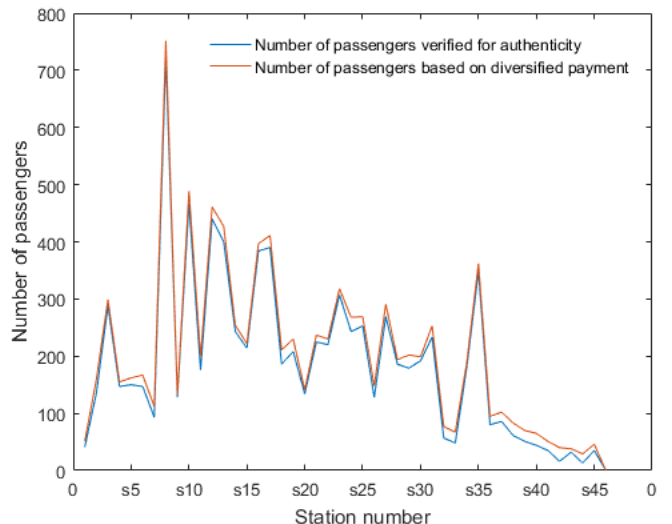
Figure 4. Statistical results of the authenticity-verified daily passenger-flow data according to station number (upward bus lines).